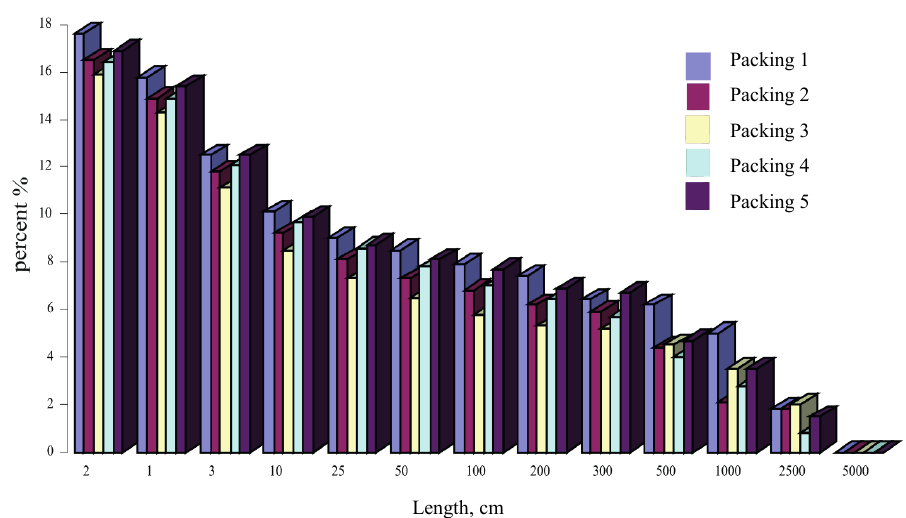
Fig. 5. Spectrum 1. Machine No. 3, material: T-36 tex (No. 28).